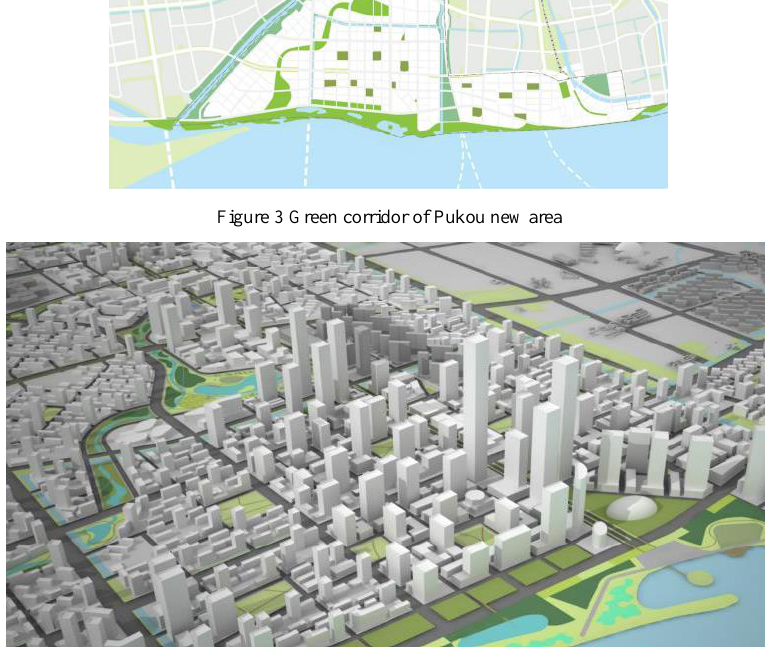
Figure 4 S-shaped strip green spaces of Pukou new